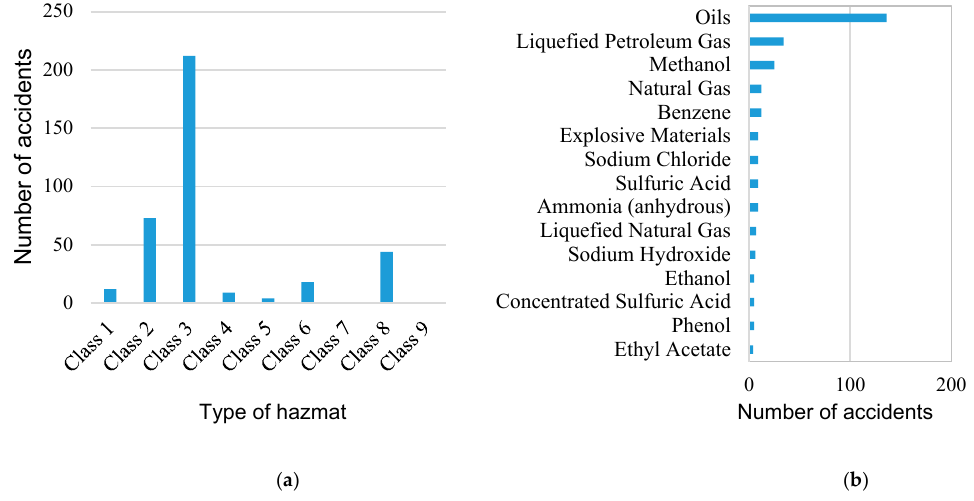
Figure 3. Hazmat classes and species statistics of the 371 HTAs. ( a ) The number of accidents for each class; and ( b ) the top 15 of hazmats involved in the 371 HTAs.